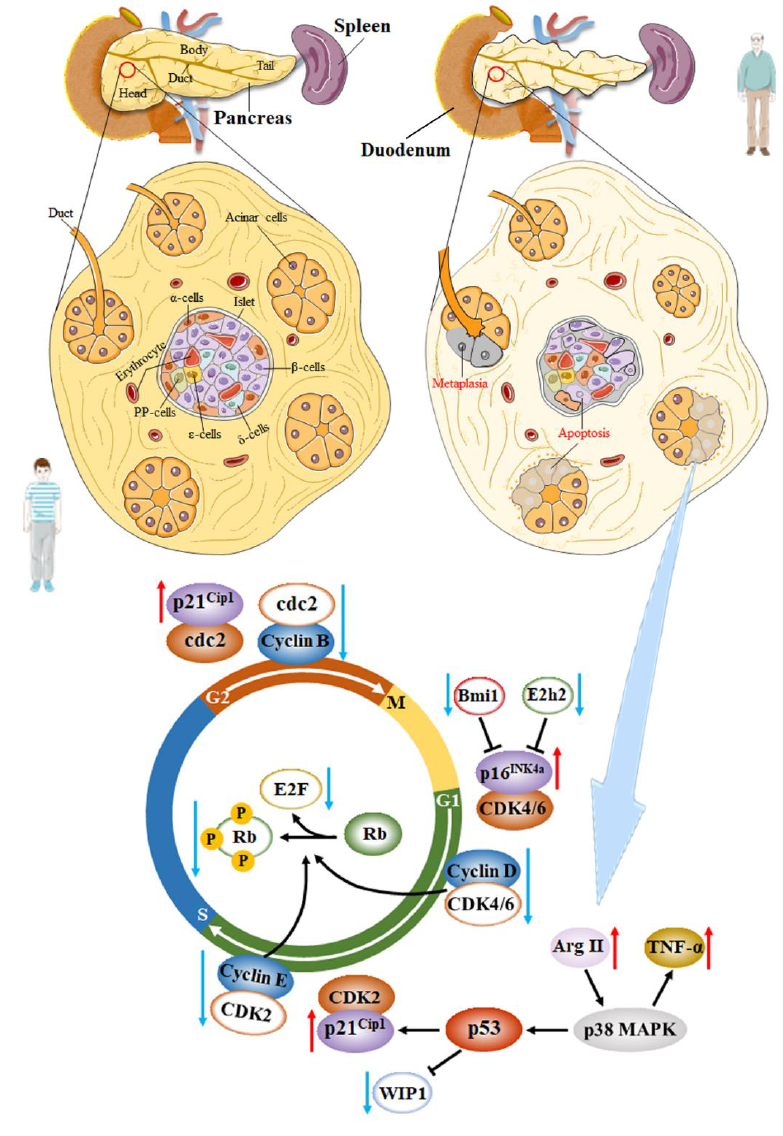
Figure 1. There was a significant reduction in β -cell proliferation and an increase in β -cell apoptosis with age. The p16 Ink4a increases with age in islets, inhibiting the phosphorylation of Rb protein by preventing Cdk4/Cdk6 binding to Cyclin D in the early G1 phase. Then the release of E2F transcription factors is blocked and contributes to cell cycle arrest. The increased expression of p16 INK4a is associated with the downregulation of Ezh2 and Bmi1. Moreover, the Arginase-II is upregulated in senescent acinar cells and activates the p38 MAPK, leading to the paracrine release of TNF- α and β -cell apoptosis next. The p38 MAPK pathway also alters the levels of WIP1 and p21 Cip1 induced by p53. The high expression of p21 Cip1 inhibits the phosphorylation of Rb protein by preventing Cdk2 binding to Cyclin E in the late G1 phase. They may also regulate the cell cycle transition from G2 to the M phase by controlling the combination of cdc2 and Cyclin B.